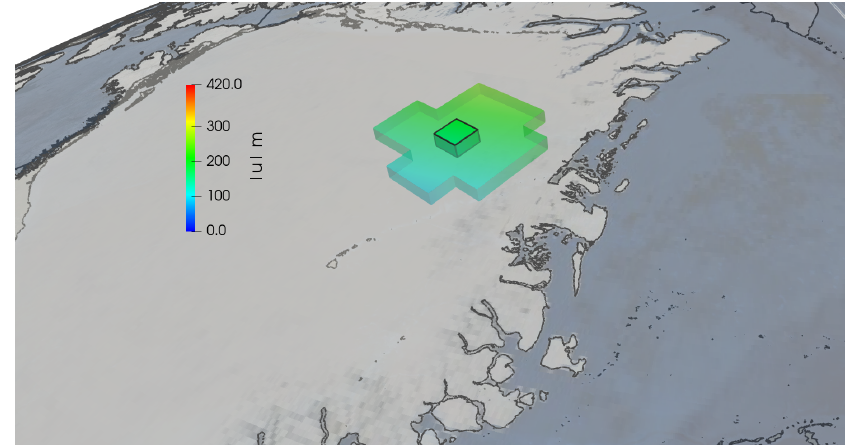
Figure 3. The simulation of isostatic adjustment with visualization of the selection of the location where the deformation tensor is extracted.